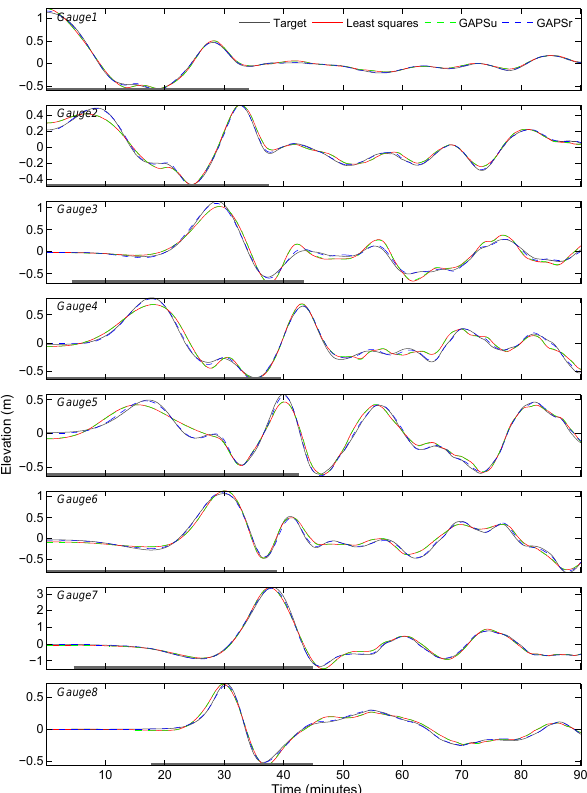
Figure 7. Comparison of waveforms at gauges. Gray bar above the time axis indicates the time range for the inversion.